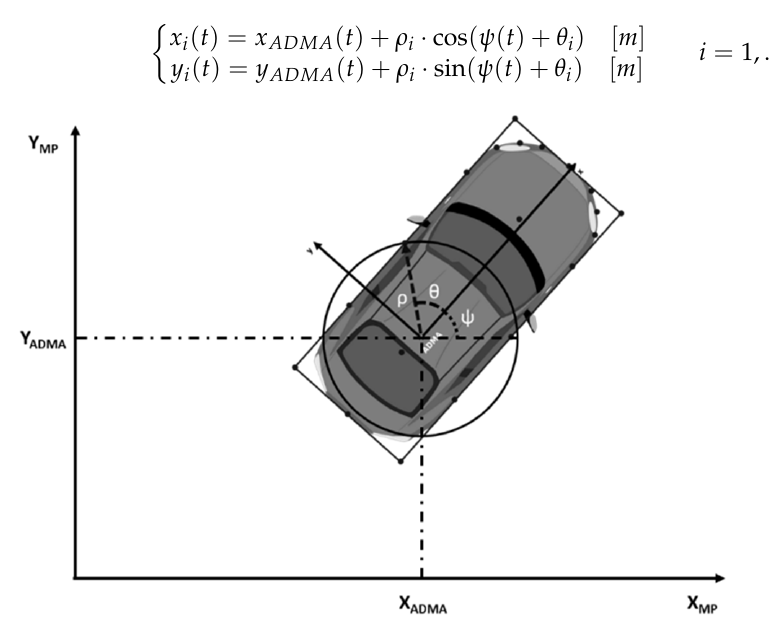
Figure 12. Vehicle kinematic maneuver.